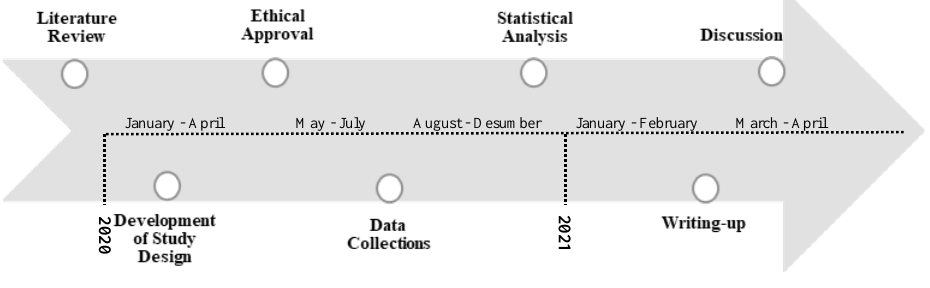
Figure 1. The Figure 1. The timeline.